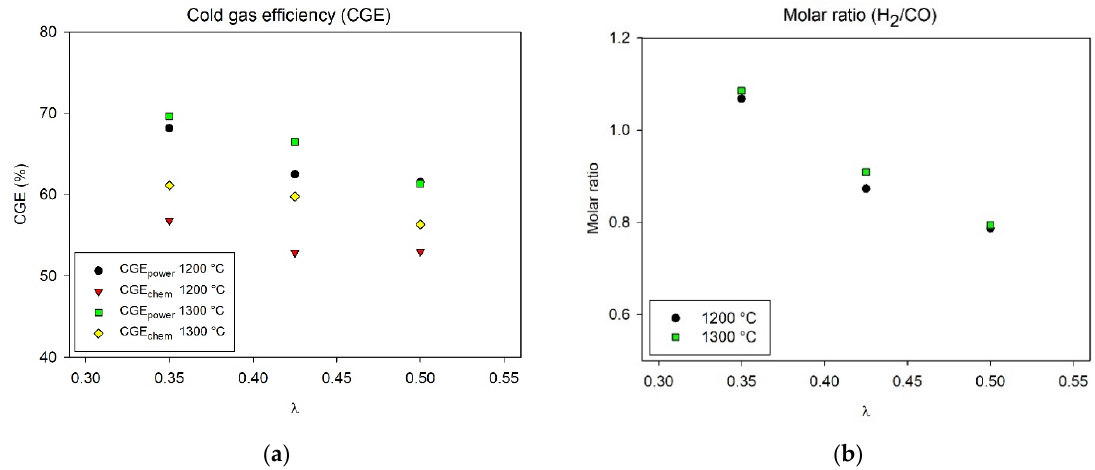
Figure 3. ( a ) Cold gas efficiency (CGE), and ( b ) Molar ratio (H 2 /CO), at different operating conditions during gasification.